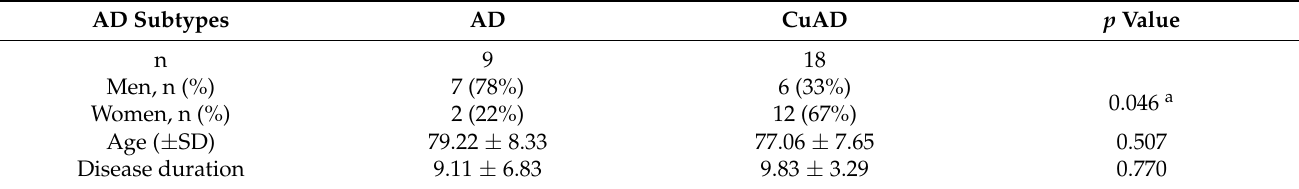
Table 3. Comparison of AD (non-Cp Cu < 1.6 µmol/L) and CuAD (non-Cp Cu ≥ 1.6 µmol/L).